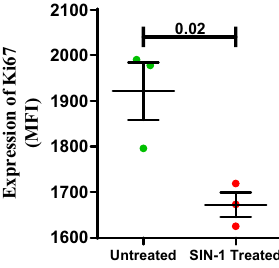
Figure 11. Effect of SIN-1 on ECFC’s Ki67 expression. Dot plot represents Ki67 expression of ECFCs in terms of median fluorescence intensity (MFI) in untreated and SIN-1 treated groups with individual data points and error bars (n = 3 for each group). Significance was assessed by student ttest and data is represented as mean ± SE. Error bar represent standard error of mean; dots represent average values of the parameter obtained from experimental duplicates p < 0.05 was considered statistically significant.